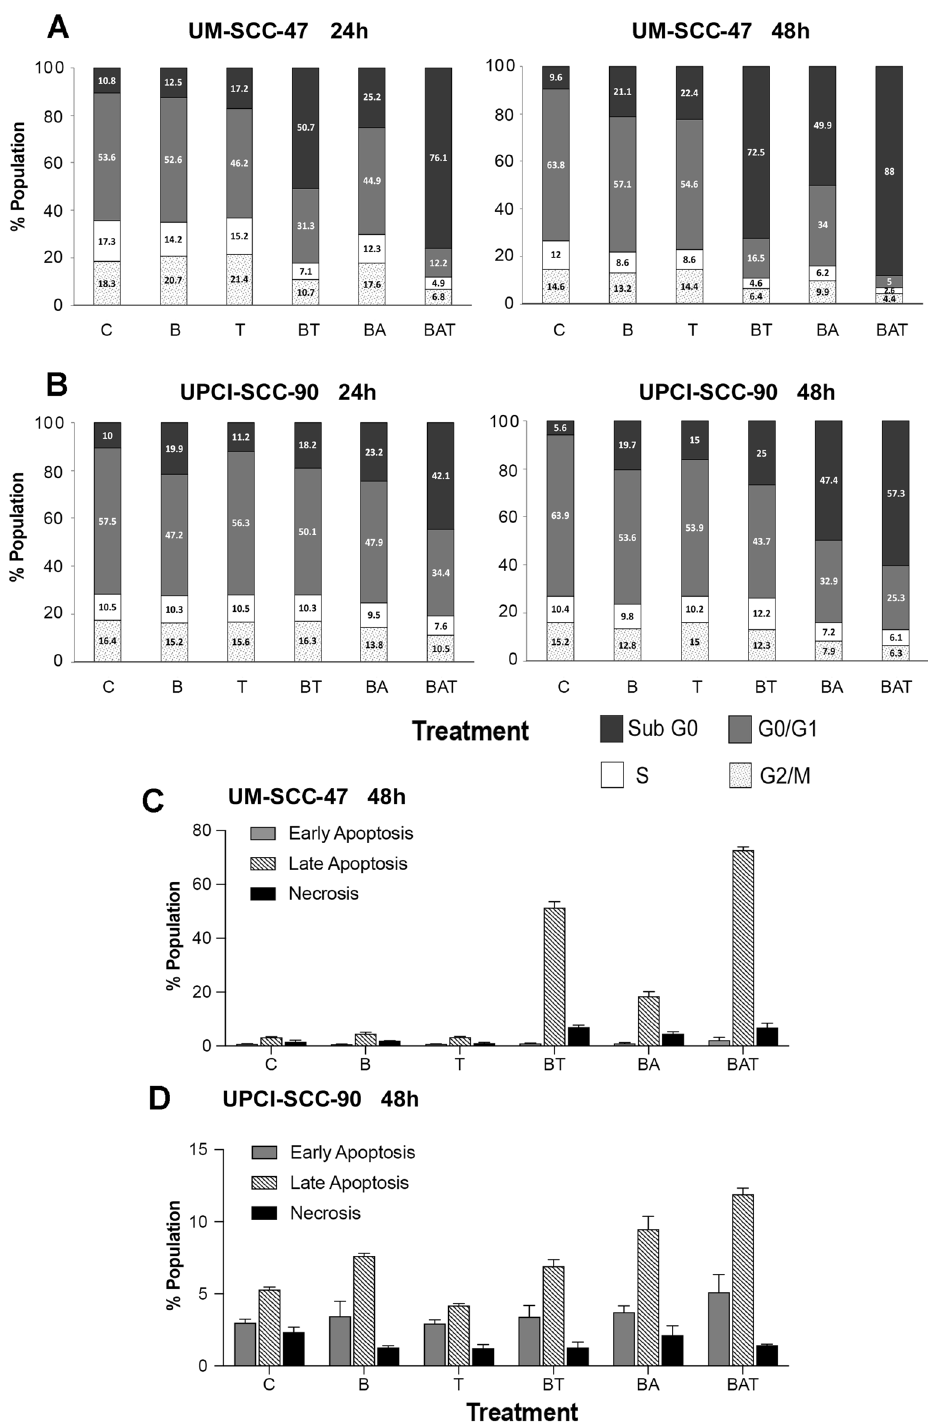
Figure 6. TRAIL and TRAILR2 antibody sensitize UM-SCC-47 and UPCI-SCC-90 cells to birinapant induced cell cycle alteration and cell death. UM-SCC-47 ( A ) and UPCI-SCC-90 cells ( B ) were treated with birinapant (500 nM) or TRAIL (50 ng/mL) alone, combined with TRAILR2 antibody (400 ng/mL), or in triple combination for 24 (left) or 48 h (right). Cells were then stained with propidium iodide (PI) after treatment and analyzed by flow cytometry. The x-axis denotes treatment conditions: C control, B birinapant, T TRAIL, A TRAILR2 antibody. BA, BT, and BAT denote combinations of treatments. Percentage of cells in different phases of the cell cycle as presented as a bar graph. UM-SCC-47 ( C ) and UPCI-SCC-90 cells ( D ) were stained with a two-color fluorescent staining followed by flow cytometry to analyze the proportions of early or late apoptotic and necrotic cells. Zombie Violet Fixable Viability Dye was used to identify cells with the damaged plasma membrane in the late apoptosis stage. Anti-phosphatidylserine (PS) antibody was used to identify apoptotic cells exposing PS on their surface at the early apoptosis stage. In all treatment groups, the proportion of apoptosis was greater than that of necrosis. Independent experiments were performed to titrate the drug doses, the combination, and time points previously. Error bars, the standard deviation of 3 replicates from a representative of independent